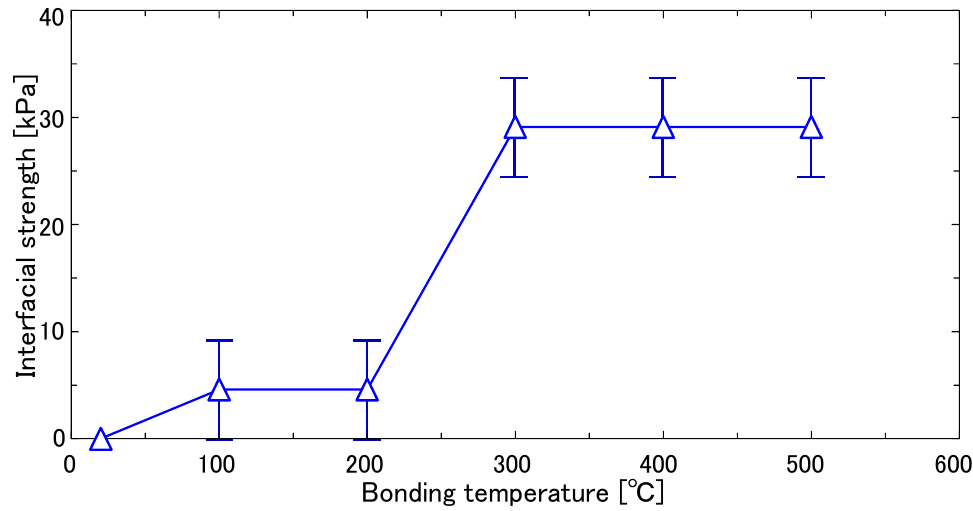
Figure 2. Interfacial bonding strength as a function of temperature for the Si/graphene/Si structure.